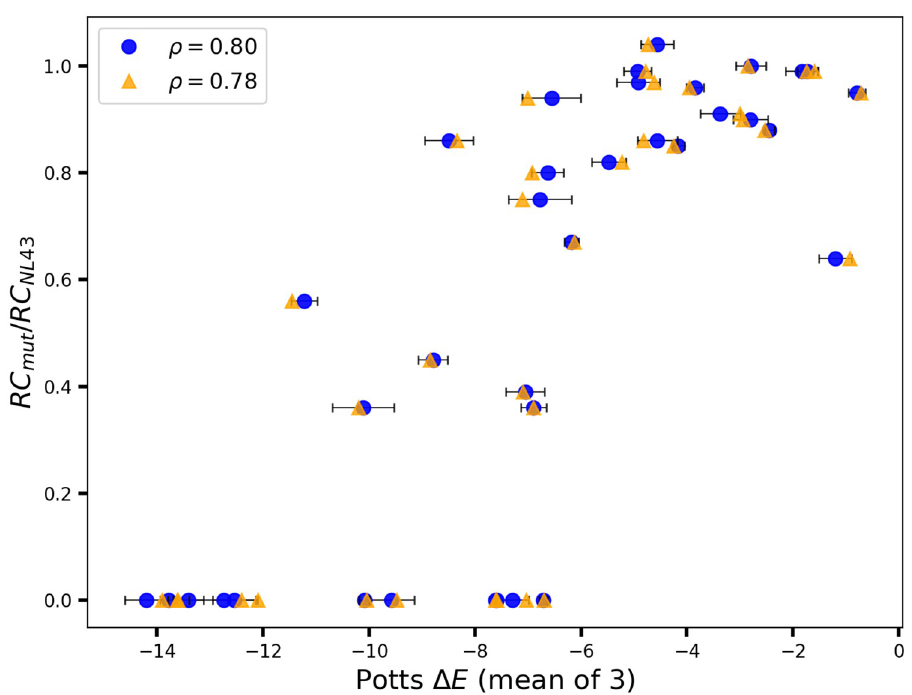
Fig 5. Error estimate in Potts model predictions of fitness. Figure shows replicative capacity based experimental fitness measurements (from [21]) compared to Potts model predicted likelihoods of mutations in HIV-1 CA. The Potts model predicted values shown in “blue circles” correspond to the mean of 3 predictions based on jackknife tests with error bars indicating the standard deviations. Random values are then picked from within each standard deviation to represent each Potts model prediction (shown as “orange triangles”) and the corresponding effect on the correlation coefficient is observed. Spearman rank-order correlation ρ = 0.8 for mean of 3 predictions, and ρ = 0.78 for random selection of data from within the margin of error. For jackknife tests, three sets of � 1024 weighted patient sequences are subsampled at random from the original MSA of � 2200 weighted sequences, and new Potts models are then inferred based on each set. For comparison, the Spearman rank-order correlation is ρ = 0.85 for the original Potts model (based on an MSA of 2200 sequences) predictions compared to experimental values (Fig 5A of S1 File). Figure shows an estimate of the error associated with Potts model predictions of likelihoods of mutants stemming from sampling of sequences in the MSA and its effect on the correspondence with experimental measures of